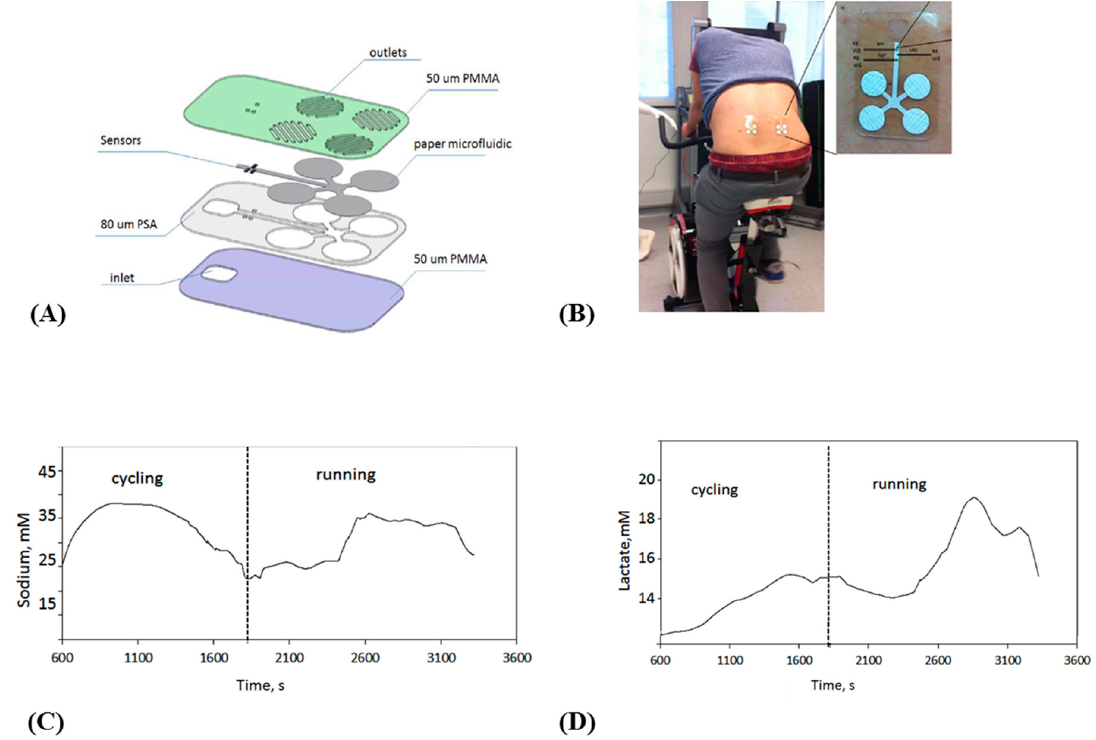
Figure 6. ( A ) Scheme of the four layers constituting the microfluidic chip (PSA: pressure sensitive adhesive). ( B ) Place where the patch is attached to the subject during an effort; inset: detail of the patch. ( C ) Measured lactate and ( D ) sodium cations in sweat during an effort. Adapted from [33].